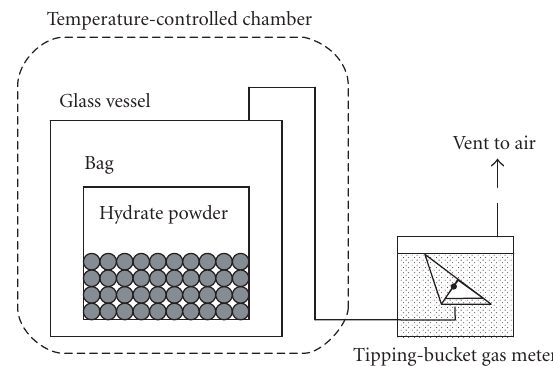
Figure 1: Schematic of the experimental apparatus for the decom- position of methane